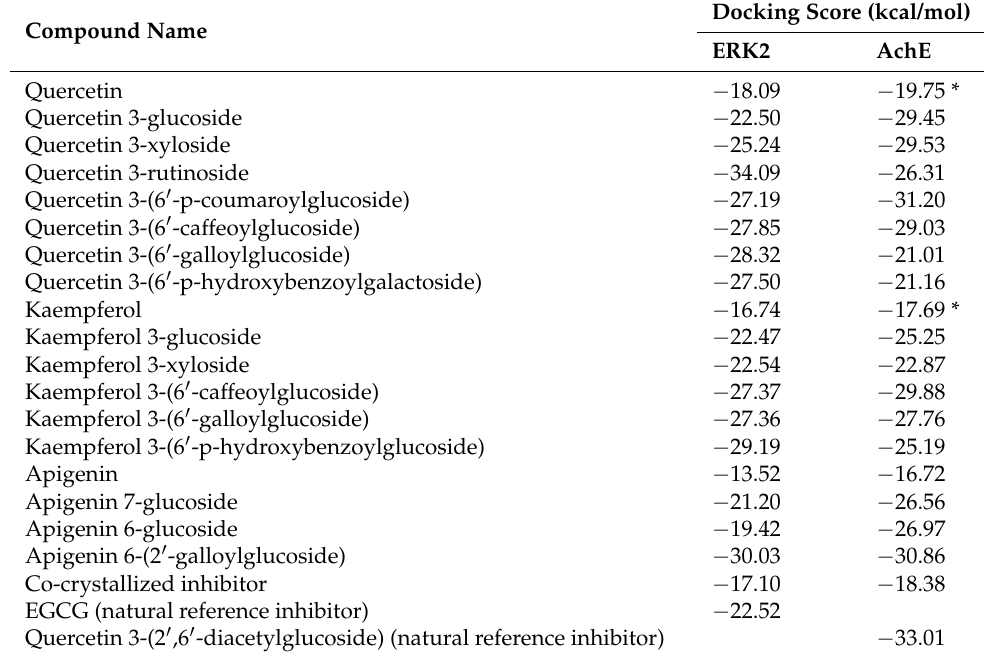
Table 5. Docking score values (kcal/mol) obtained upon docking H. abyssinica polyphenols into ERK2 and